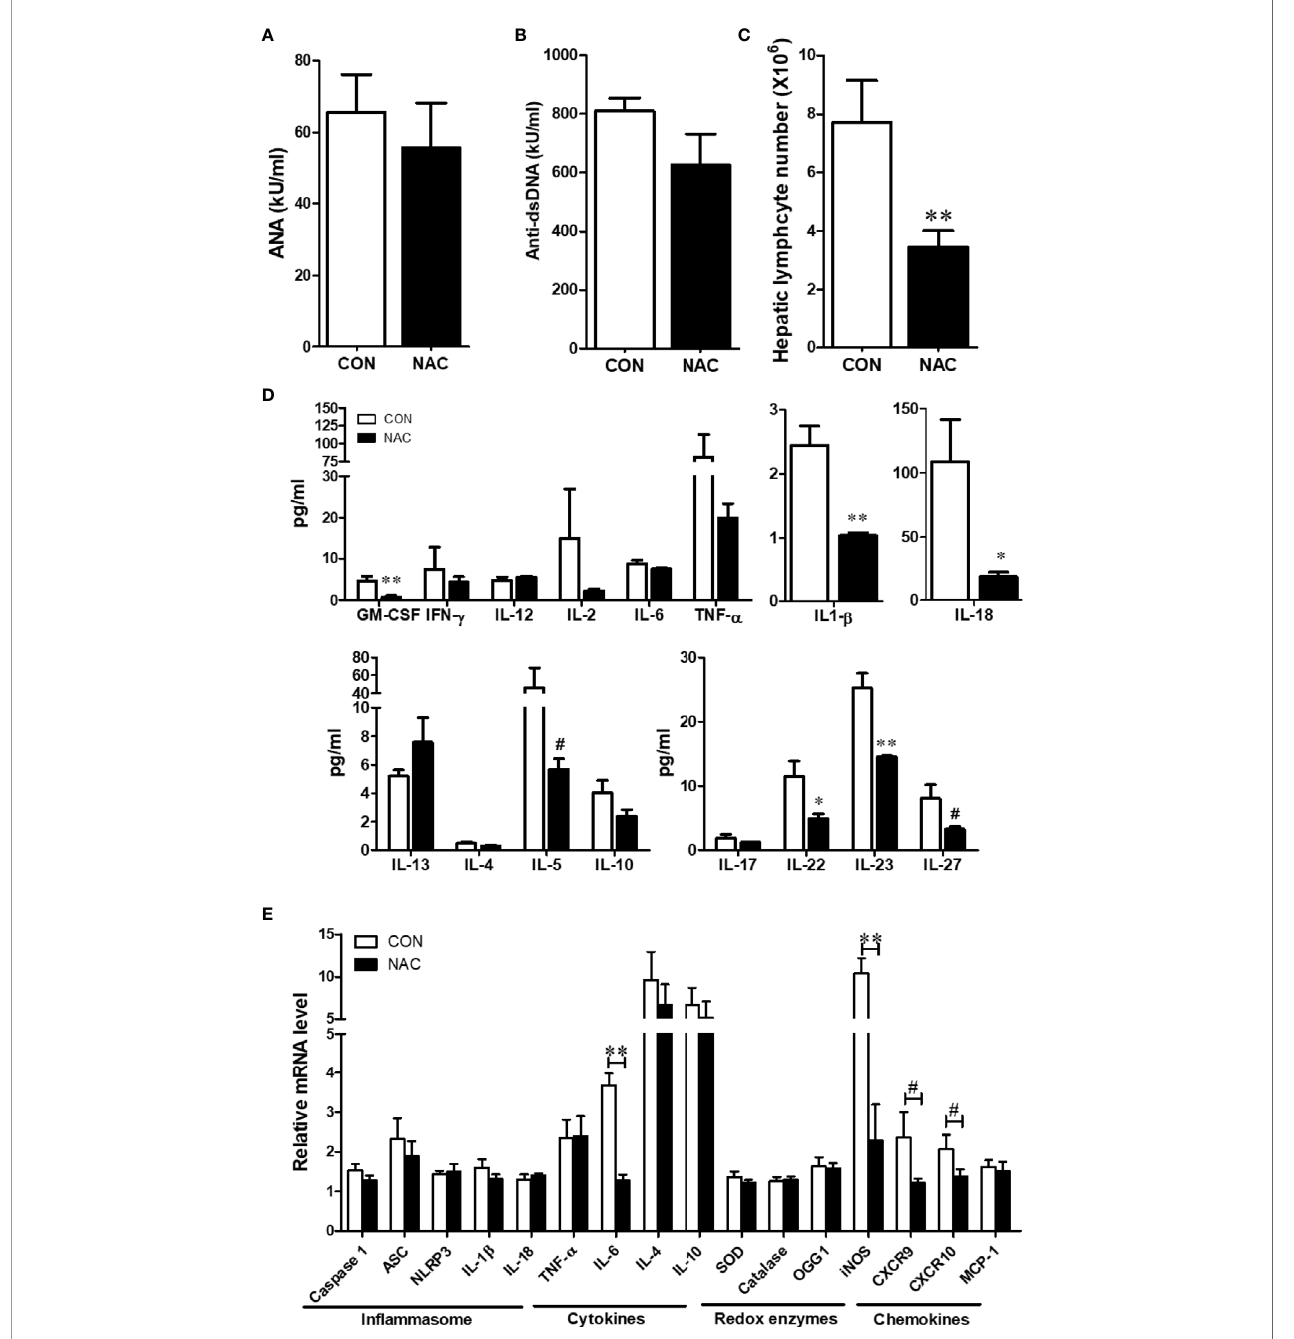
FIGURE 9 | NAC treatment attenuated the auto-in fl ammatory responses in MRL/lpr mice. Serum ANA (A) and anti-dsDNA (B) levels in the control and NAC-treated mice. (C) Diminution of hepatic lymphocytes following NAC treatment. (D) Serum cytokines, measured using a multiplex assay in the control and NAC-treated mice. (E) RT-PCR for markers of in fl ammasome activation, cytokines, redox-related enzymes and chemokines in the control and NAC-treated mice. Results are mean ± SEM. n = 5 * p < 0.05; ** p < 0.01, # p <